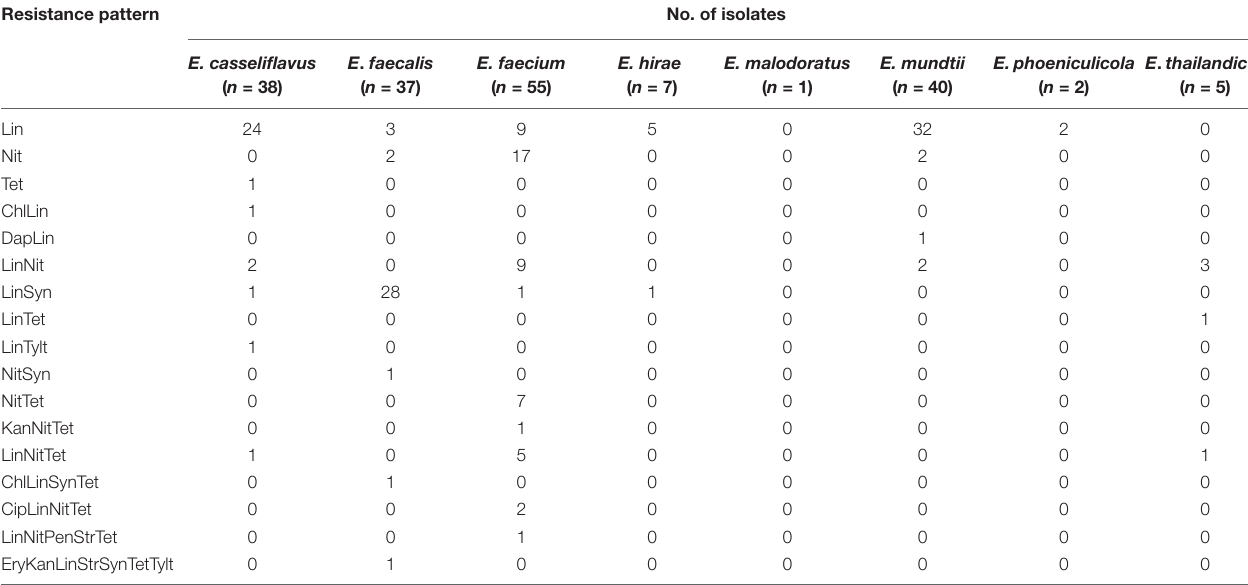
TABLE 9 | Resistance patterns of Enterococcus spp. from the irrigation return flows and background canal site. Resistance pattern No. of